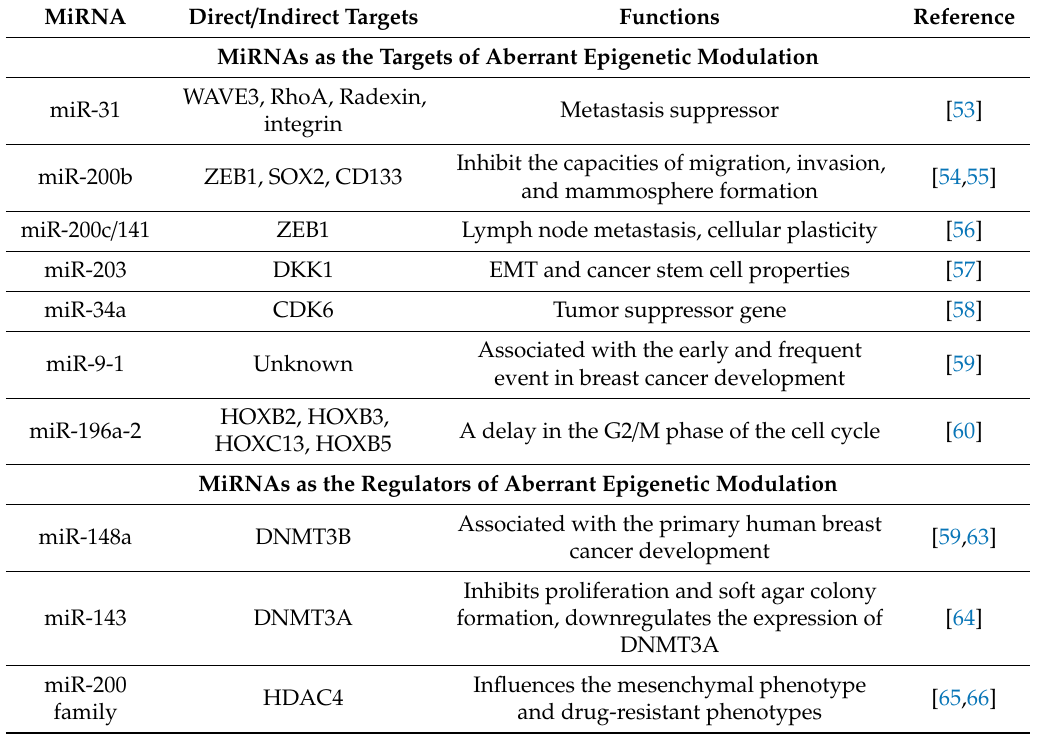
Table 2. MiRNAs associated with epigenetic mechanisms in